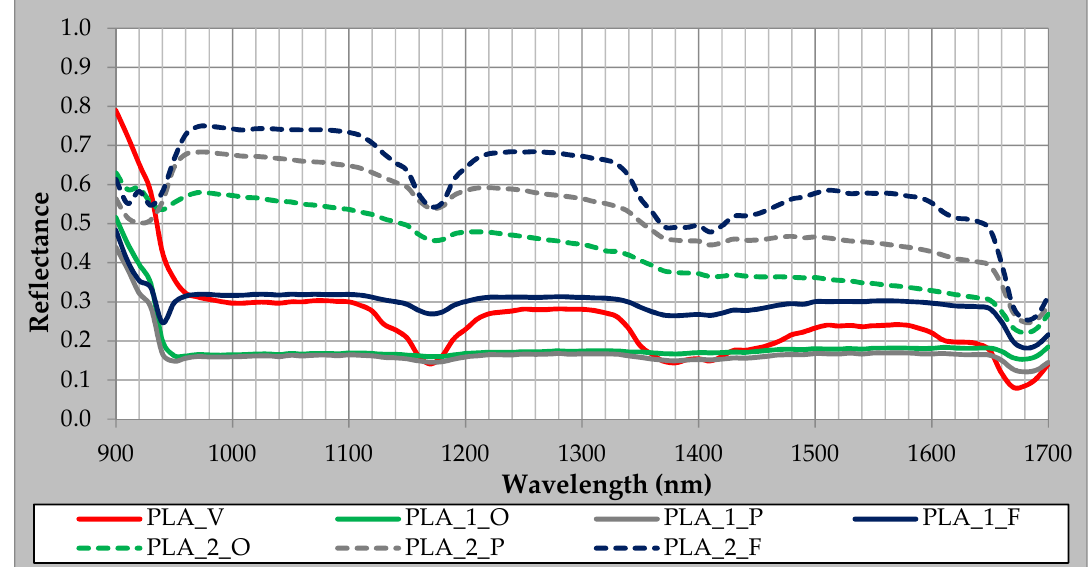
Figure 4. Spectral signatures of PLA samples in the NIR region detected with the linear spectrometer.